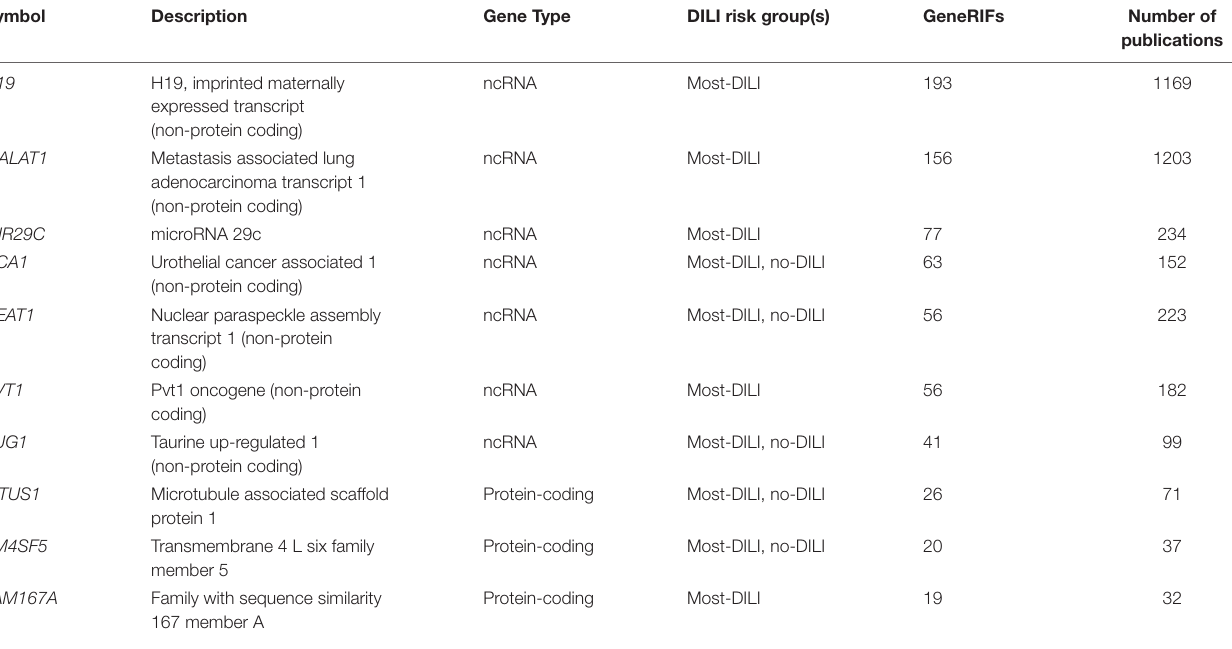
TABLE 5 | Top 10 dark genes by number of GeneRIFs with their corresponding number of publications indexed on PubTator.